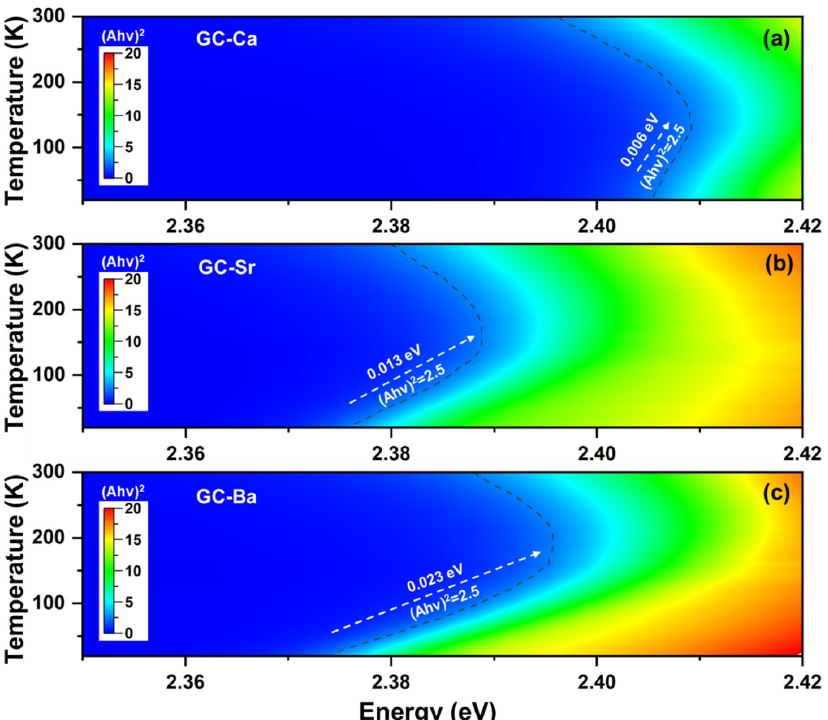
Figure 4. Temperature-dependent absorption edge evolution of ( a ) GC-Ca, ( b ) GC-Sr, and ( c ) GC-Ba in the heating process from 20 to 300 K at a temperature ramping rate of 5 K/min. The intensity values of ( α h ν ) 2 were calculated from absorption spectra by using the Tauc plot method.